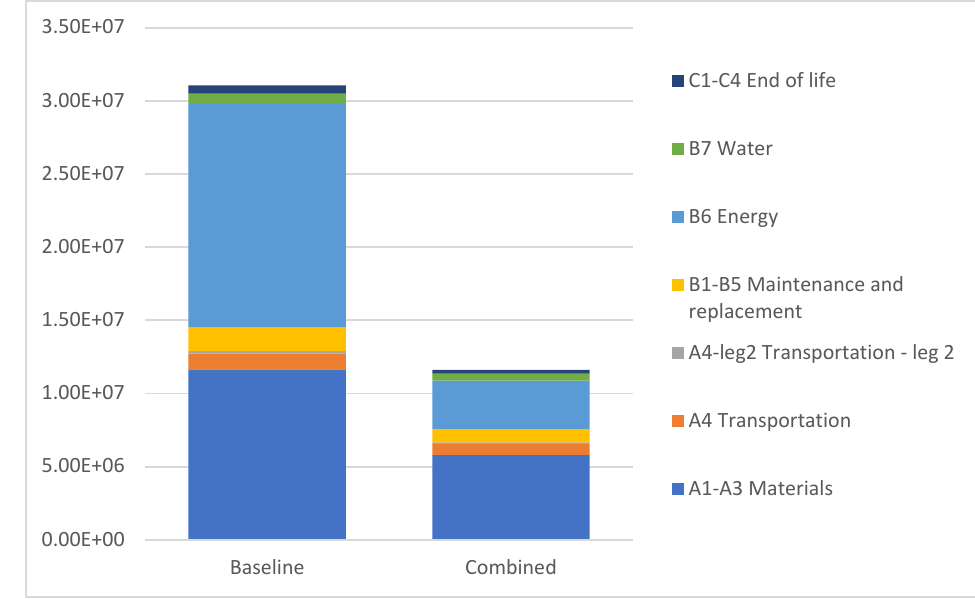
Figure 11. Comparison between baseline and incorporation of every decarbonization strategy